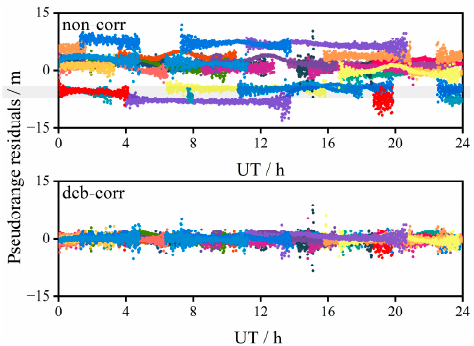
Figure 12. Pseudorange residuals of IF123-0 model at AREG.